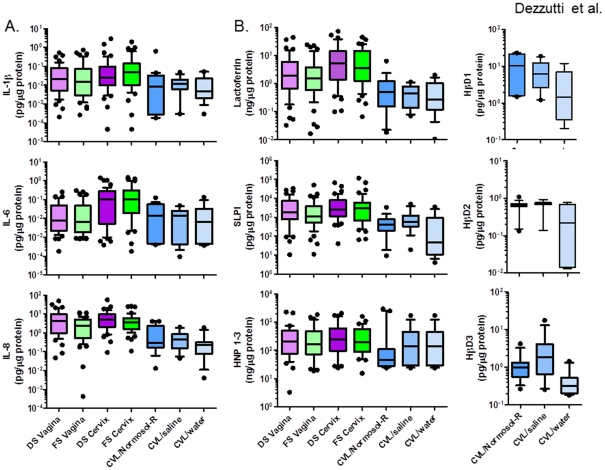
Levels of mediators in female genital tract secretions collected by swabs and cervicovaginal lavages (CVL).Female genital tract secretions were collected by Dacron swabs (DS) and flocked swabs (FS) from the vagina and the endocervix (cervix) and by CVL using Normosol-R, saline, or water. (A) Cytokine levels and IL-8 were measured by luminex technology. (B) Antimicrobial protein levels were measured by commercially available ELISA. β-defensins were measured only in CVL due to limited sample volume from the swabs. Data are presented as box and whisker plots where the median is the horizontal line through the vertical box which represents the 25–75th percentiles. Values within the 10–90th percentiles are represented by the error bars. Outliers are shown by filled circles. Data were log-transformed and significant changes were determined using linear mixed model and discussed in the results section.